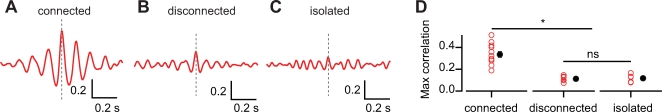
Cross-correlation between prelimbic and infralimbic cortex.(A,B,C) Cross-correlation between prelimbic and infralimbic cortex in a connected slice (A) disconnected slice (B) and between two isolated mini-slices. Vertical dashed line at t = 0 s. (D) Maximal cross-correlation (connected n = 12; disconnected n = 6; isolated slices n = 5, p<0.01).